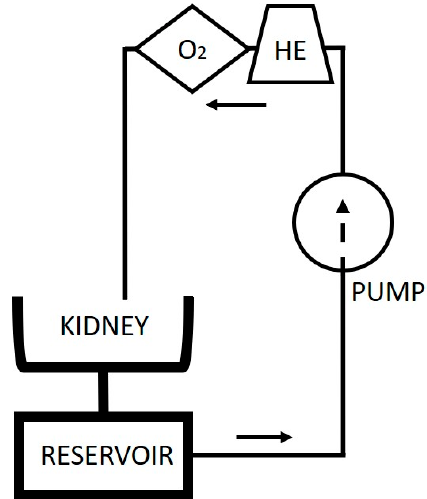
Figure 1. A schematic of a kidney perfusion circuit: The presence of a heat exchanger (HE) and gas exchanger (O 2 ) depends on the perfusion mode. HE, heat exchanger; O 2 , gas exchanger